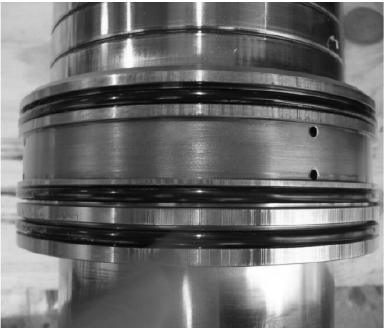
Figure 11 – Abrasive damage of the regulating valve